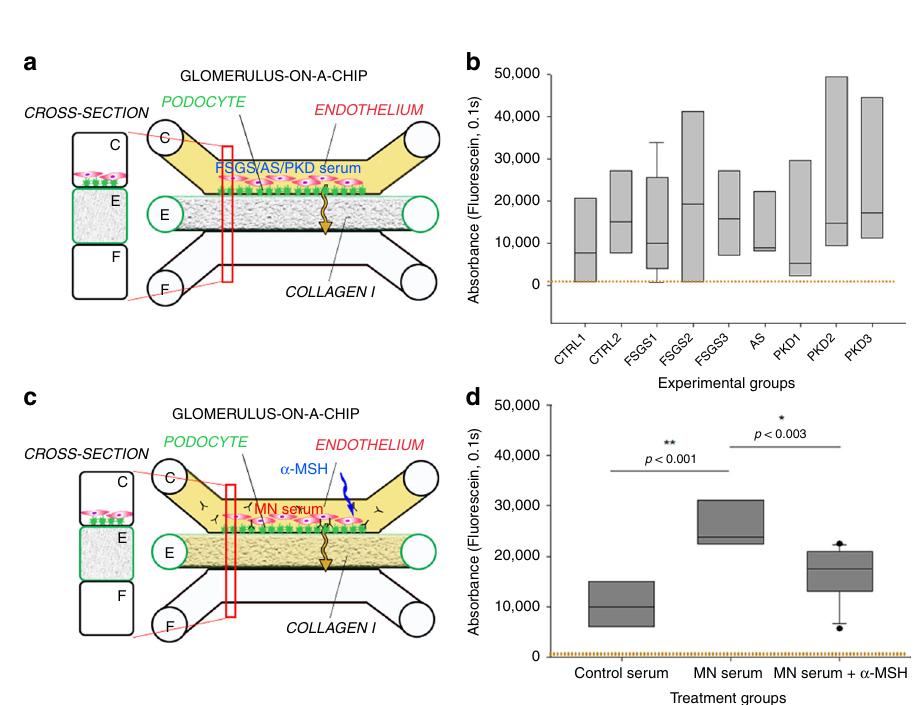
Fig. 7 Validation of the hAKPC-P GOAC system as a diagnostic and drug screening platform. a Scheme of GOAC albumin permselectivity assay and exposure to serum from patients affected by FSGS, AS, and PKD. Following a 24 h incubation with media supplemented with 0.5% serum from healthy individuals (CTRL1 and CTRL2) or CKD patients, albumin-FITC is applied to channel C (yellow) and fl ow-through presents in channel F. b Box plot graph of fl uorescein absorbance in fi ltrate after 60 min following 24 h incubation with serum from healthy individuals (CTRL1 and CTRL2), patients affected by FSGS (FSGS1, FSGS2, and FSGS3), AS, and PKD (PKD1, PKD2, and PKD3). As expected, no statistically signi fi cant differences were detected among groups. Number of replicates for chips used in b as follow: CTRL1: #7; CTRL2: #8; FSGS1: #9; FSGS2: #3; FSGS3: #4; AS: #4; PKD1: #5; PKD2: #5; PKD3: #5. c Scheme of GOAC albumin permselectivity assay and exposure to healthy or MN serum with or without α -MSH. Following a 24 h incubation with media supplemented with 0.5% serum from healthy individuals (CTRL2), MN patient (MN3) or MN patient (MN3) + α -MSH, albumin-FITC is applied to channel C (yellow) and fl ow-through presents in channel F. d Box plot graph of fl uorescein absorbance in fi ltrate after 60 min following 24 h incubation with serum from healthy individuals or MN with or without supplementation with 10 ng/ml of α -MSH for 24 h. Quanti fi cation of proteinuria (albumin-FITC) was performed by measuring absorbance ( fl uorescein, 0.1 s) of fl ow-through for hAKPC-P + hGEC at 60 min Number of replicates for chips used in d is as follows: CTRL2: #6 : MN3: #9; MN3 + a-MSH: #11. Signi fi cant differences were determined by a one-way ANOVA and Holm – Sidak post hoc test. Box plots show the median, the 25th and 75th percentiles, whiskers (median ± 1.5 times interquartile range), and outliers (solid